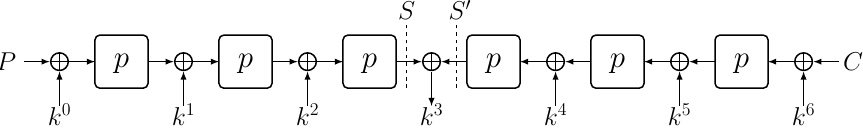
Figure 5: Attack sketch for six round cipher with ideal round